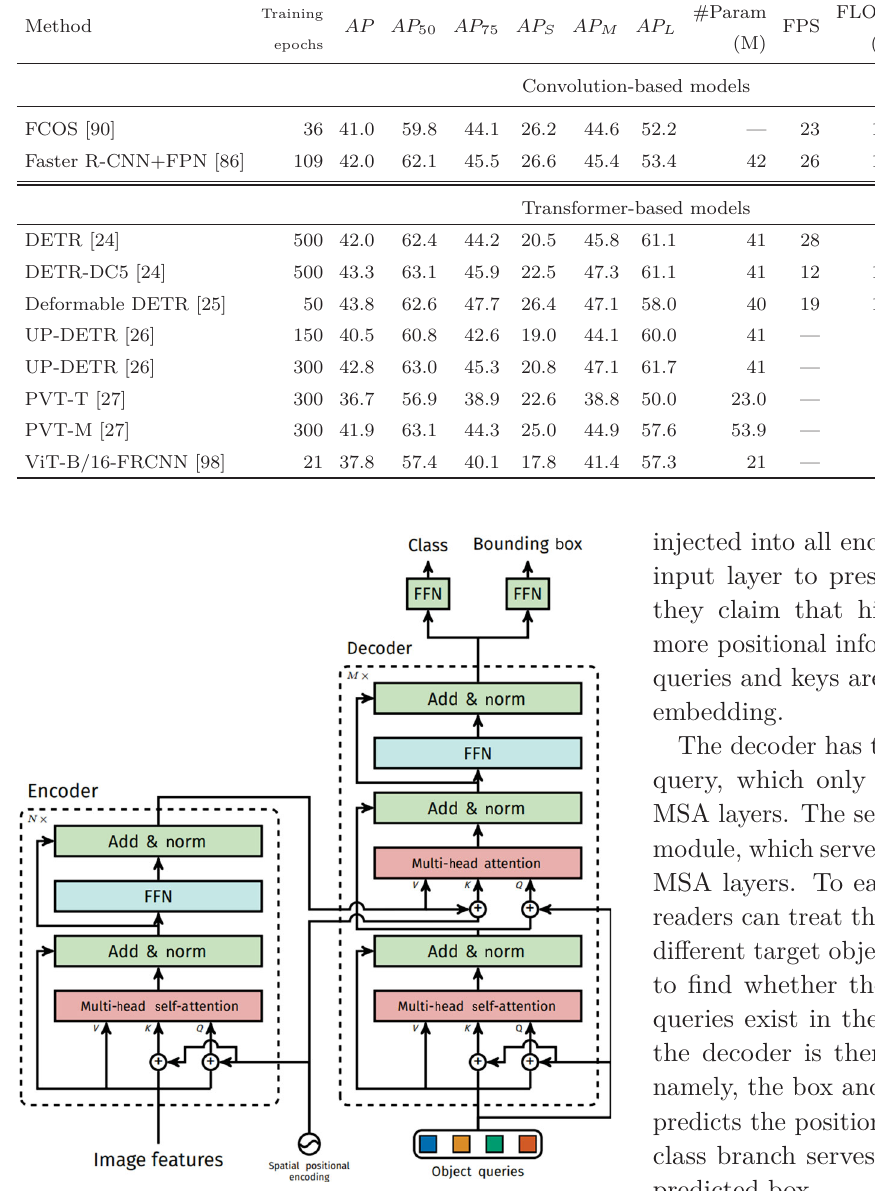
extractor. We introduce the encoder and decoder modules in